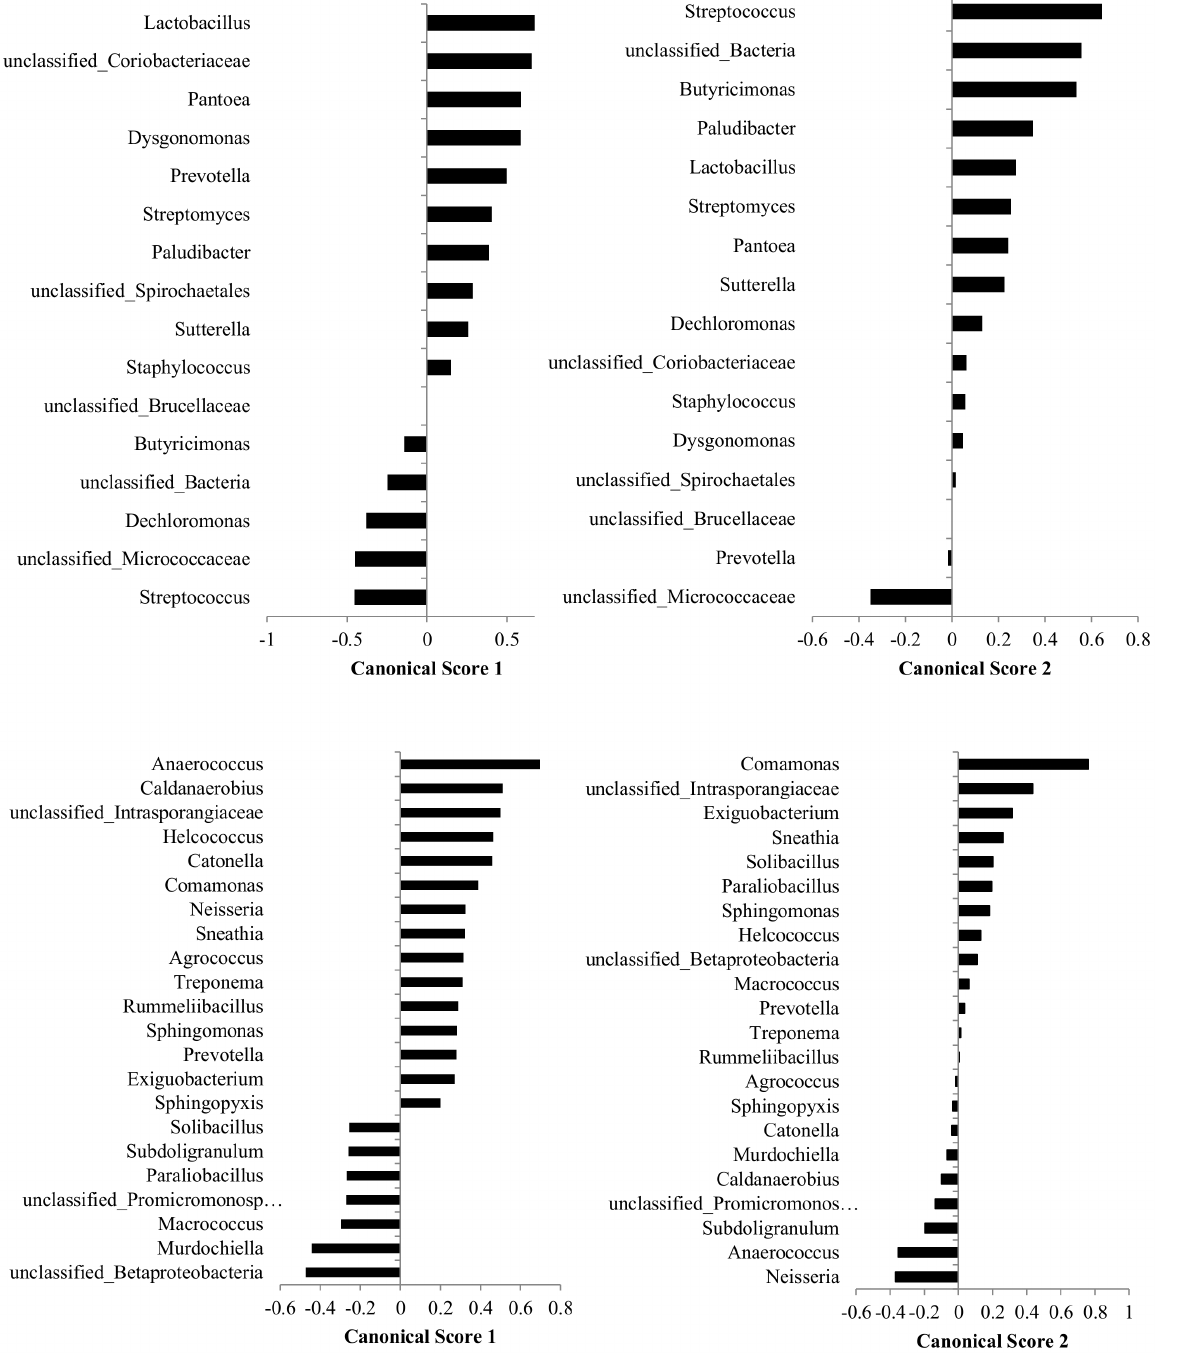
Figure 4. Canonical scores 1 and 2 for genera that were found to be significant for the discriminant analysis (displayed in Figure 2III) of milk microbiome by milk samples groups performed using groups 1 – 3 (top). Canonical scores 1 and for genera that were found to be significant for the discriminant analysis (displayed in Figure 2IV) of milk microbiome that used farm as the categorical variable and genera prevalences for the milk samples from groups 1–3 (bottom). higher prevalences of Paenibacillus were associated with lower log10SCC. Particularly Paenibacillus is of interest as it has been associated with both biocontrol of pathogenic bacteria [33] and a decreased shelf life of milk and milk products [34].